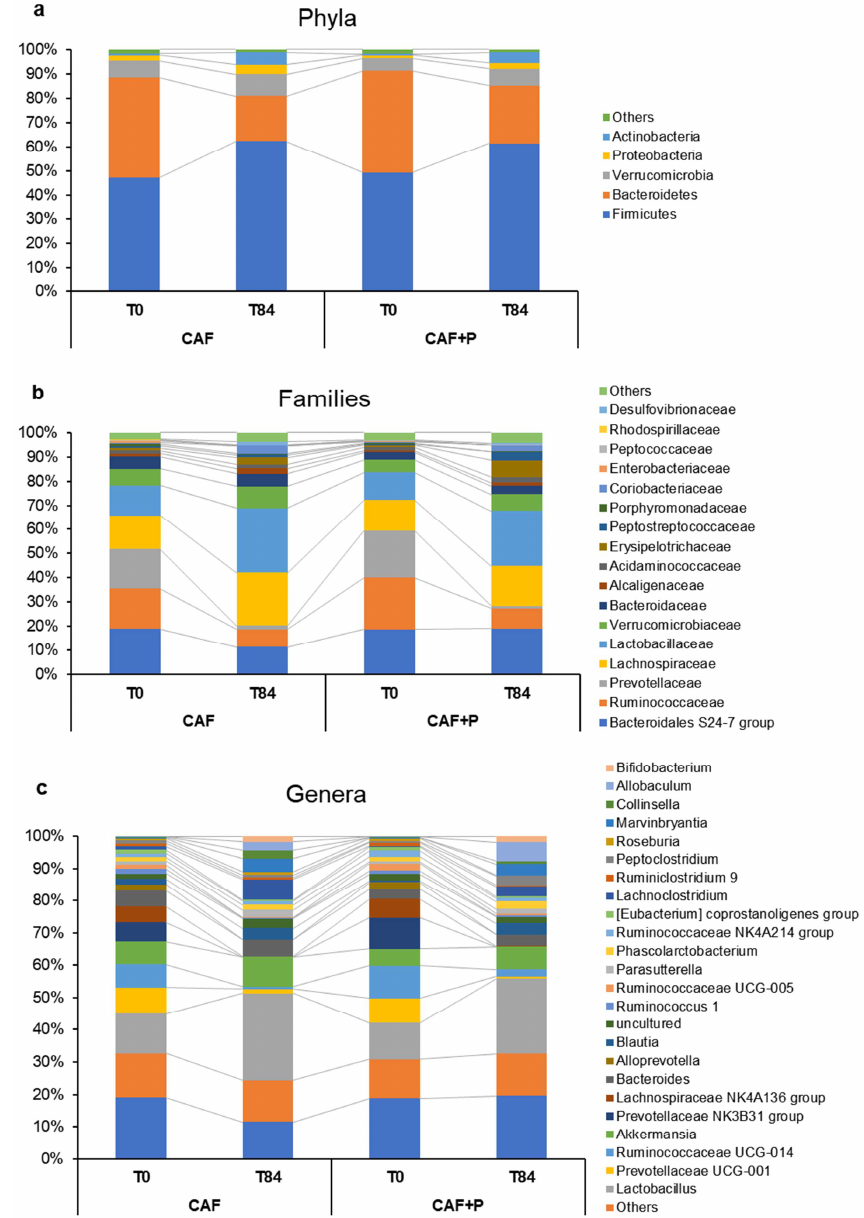
Figure 8. Histogram of relative abundance. The x-axis represents groups (CAF and CAF+P) and sampling times (T0 and T84 days) and the y-axis represents relative abundance presented as per- centage. ( a ) Relative abundance of the top 5 phyla; ( b ) Relative abundance of the top 17 families; ( c ) Relative abundance of the top 25 genera; other species were combined as “Others”. CAF: cafeteria; P: probiotic